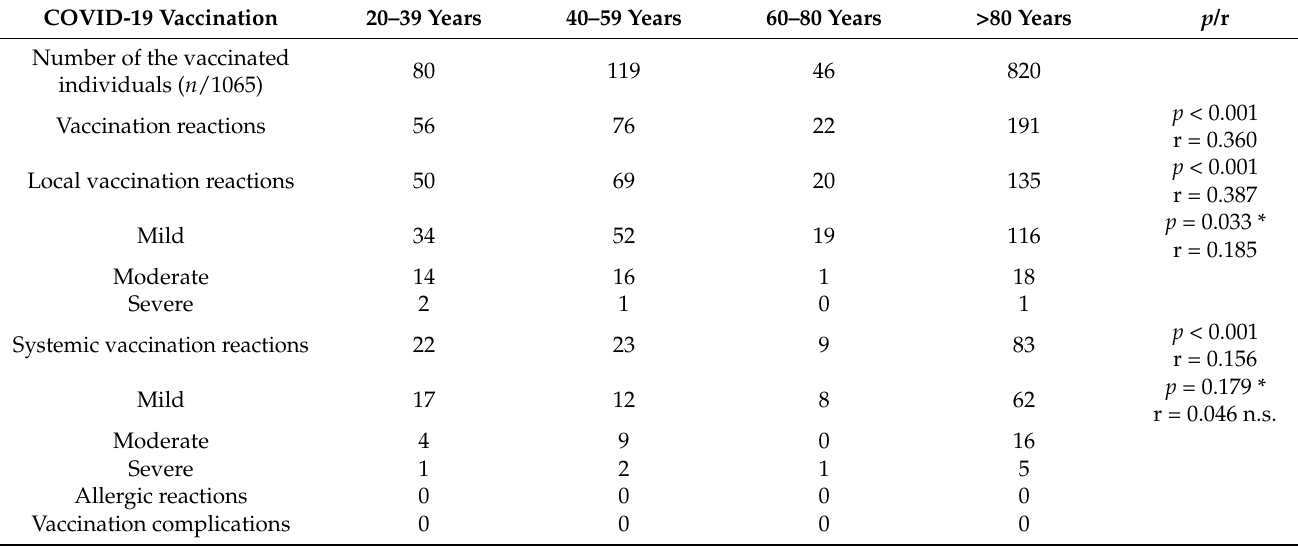
Table 3. Age-group-graded vaccination